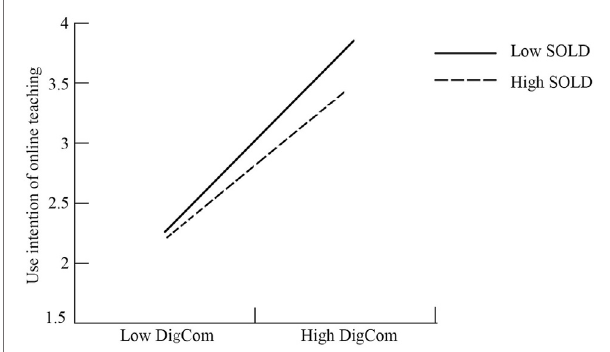
FIGURE 2 | Moderating role perceived students ’ online learning dif fi culties (SOLD) between teachers ’ digital competence (DigCom) and intention to use online